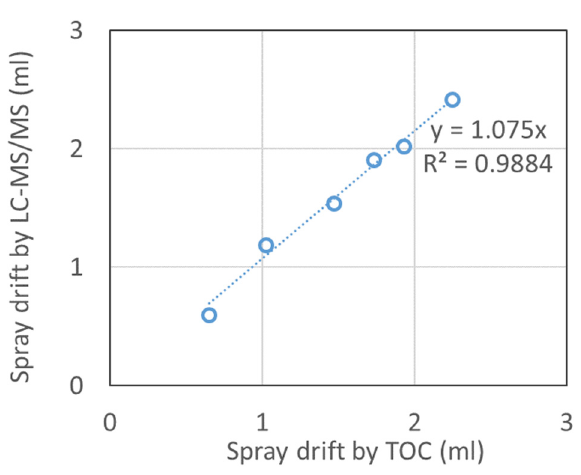
Figure 3. Comparison of spray drifts quantified by TOC and LC-MS/MS.